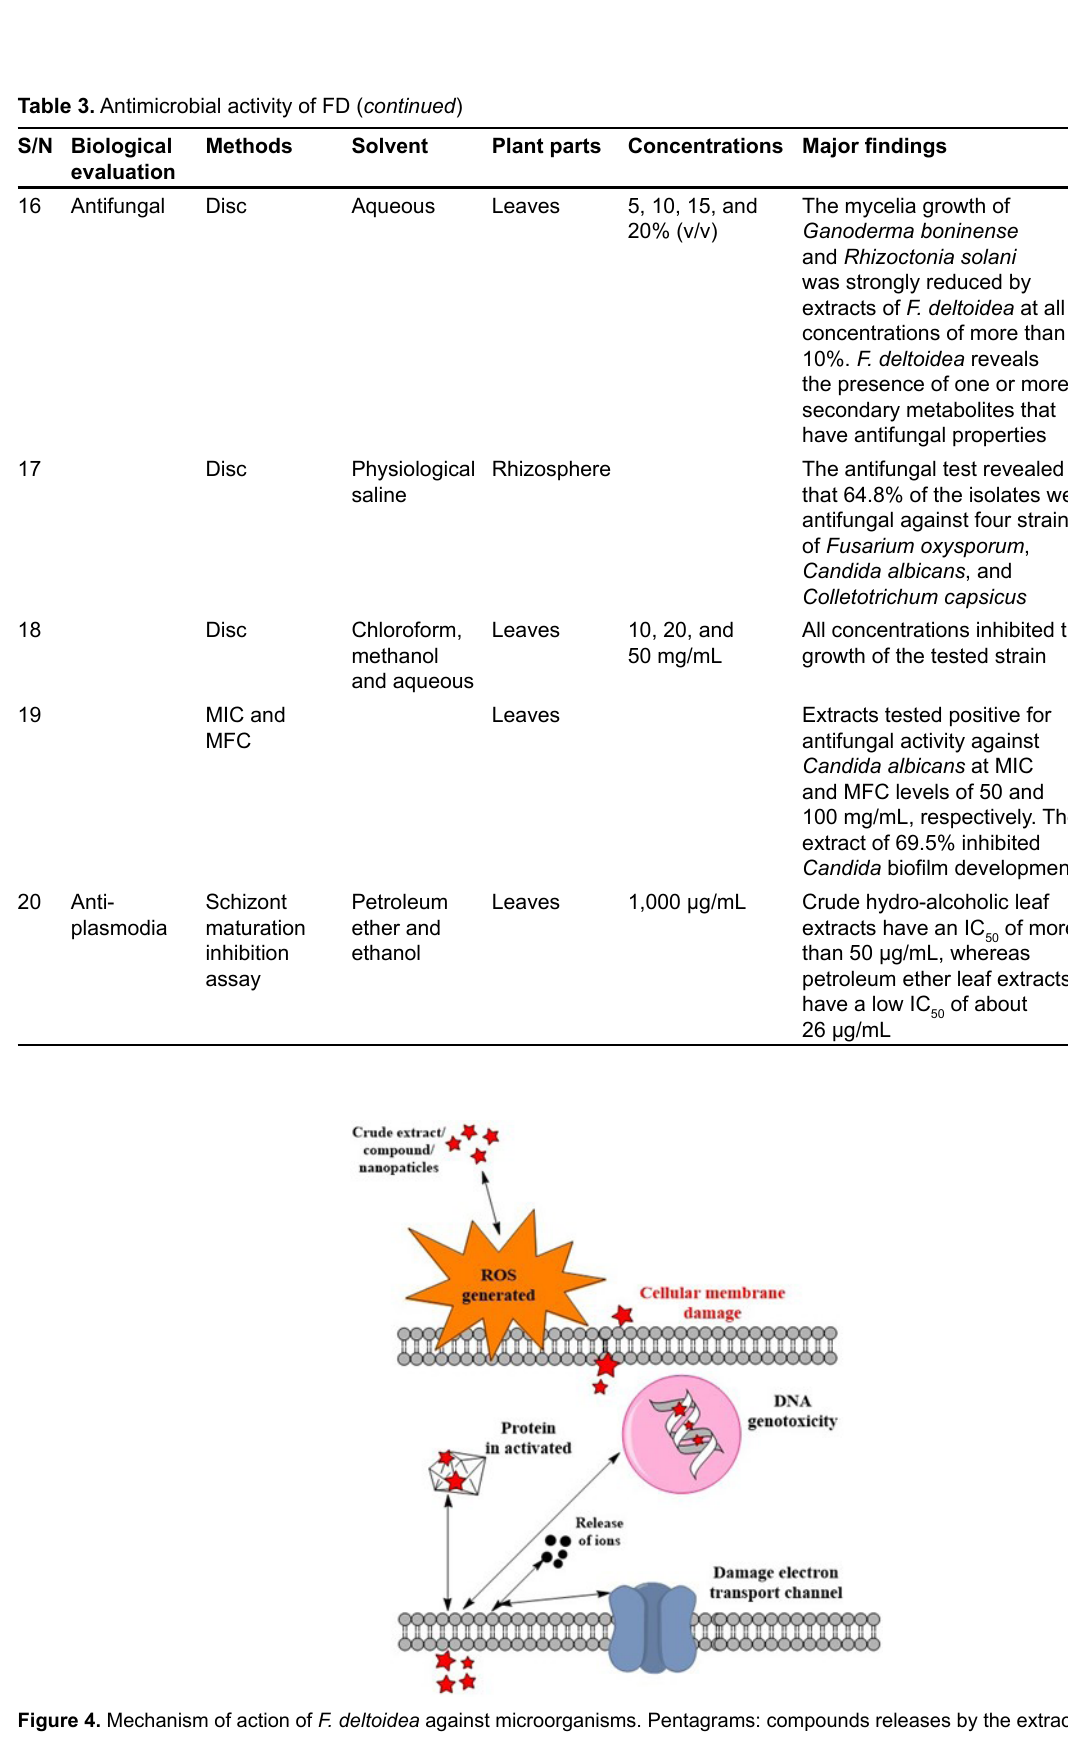
Figure 4. Mechanism of action of F. deltoidea against microorganisms. Pentagrams: compounds releases by the extract Effects on the endocrine